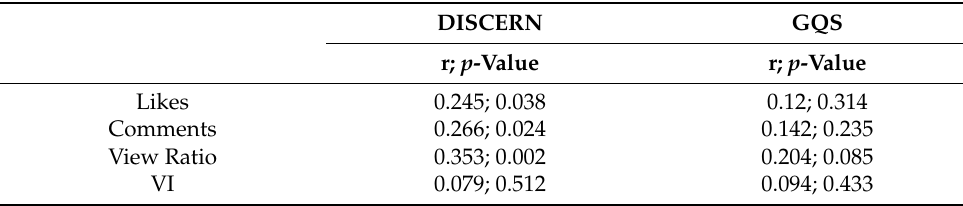
Table 4. Correlation between DISCERN and GQS with popularity indexes. DISCERN GQS r; p -Value r; p -Value Likes 0.245; 0.038 0.12; 0.314 Comments 0.266; 0.024 0.142; 0.235 View Ratio 0.353; 0.002 0.204; 0.085 VI 0.079; 0.512 0.094;